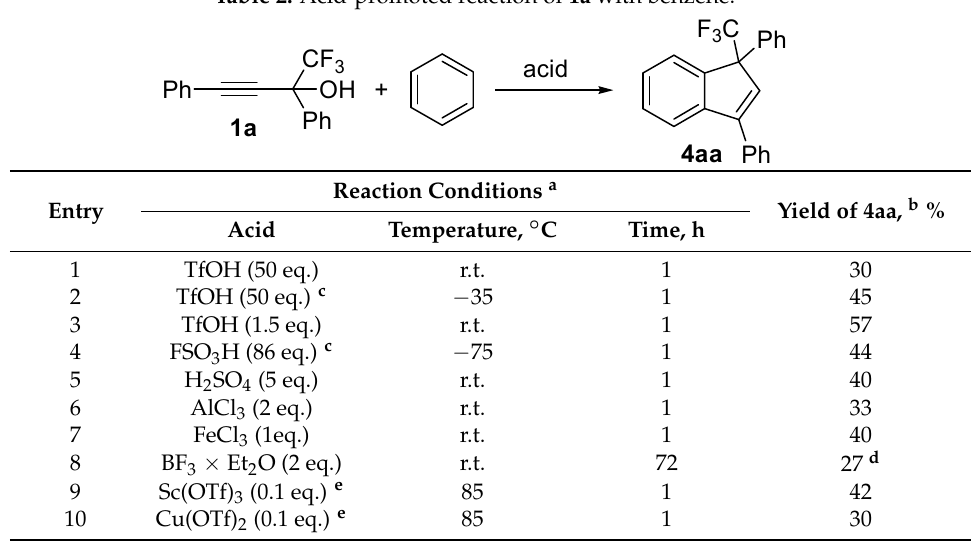
Table 2. Acid-promoted reaction of 1a with benzene.